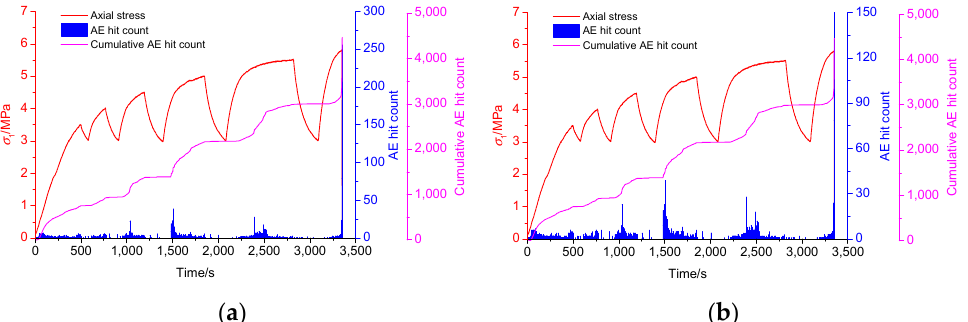
Figure 7. AE hit count and axial stress versus time curves for coal specimen subjected to cyclic load and unloading. ( a ) AE hit count scale not magnified; ( b ) AE hit count scale magnified ~2×.